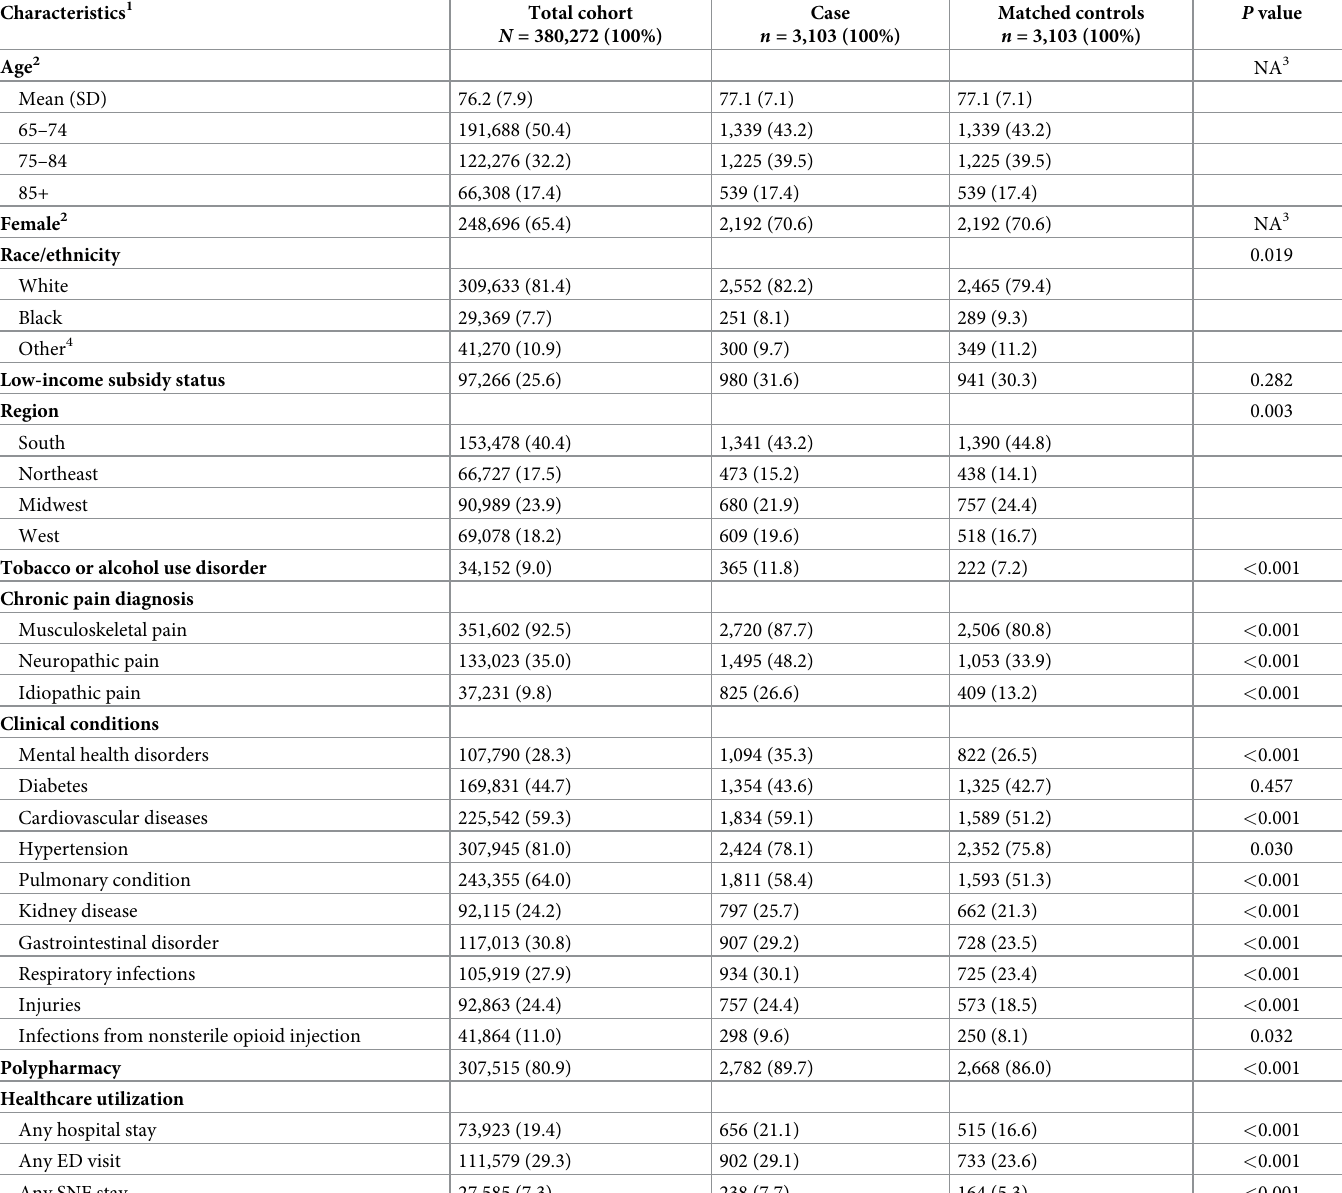
Table 1. Characteristics of the total cohort, cases who had an incident ORAE encounter, and matched controls of older adults with CNCP who were new users of prescription opioids between 2011 and 2018. Characteristics